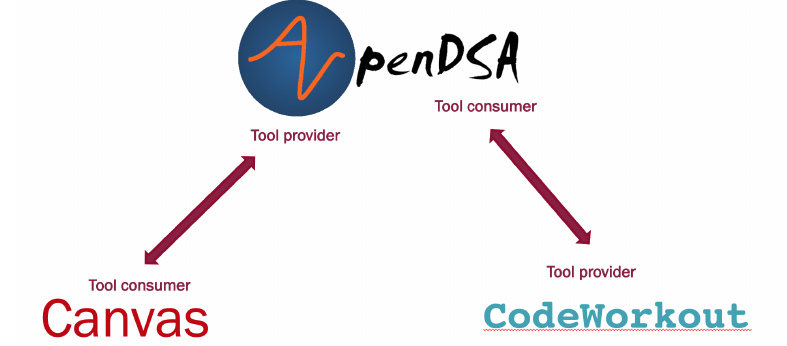
Figure 7. OpenDSA New Architecture.